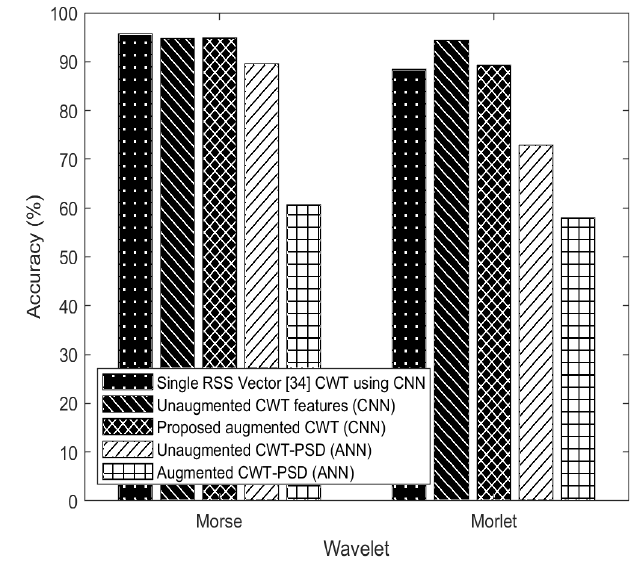
Figure 8. Accuracy results for specific reference point estimation.